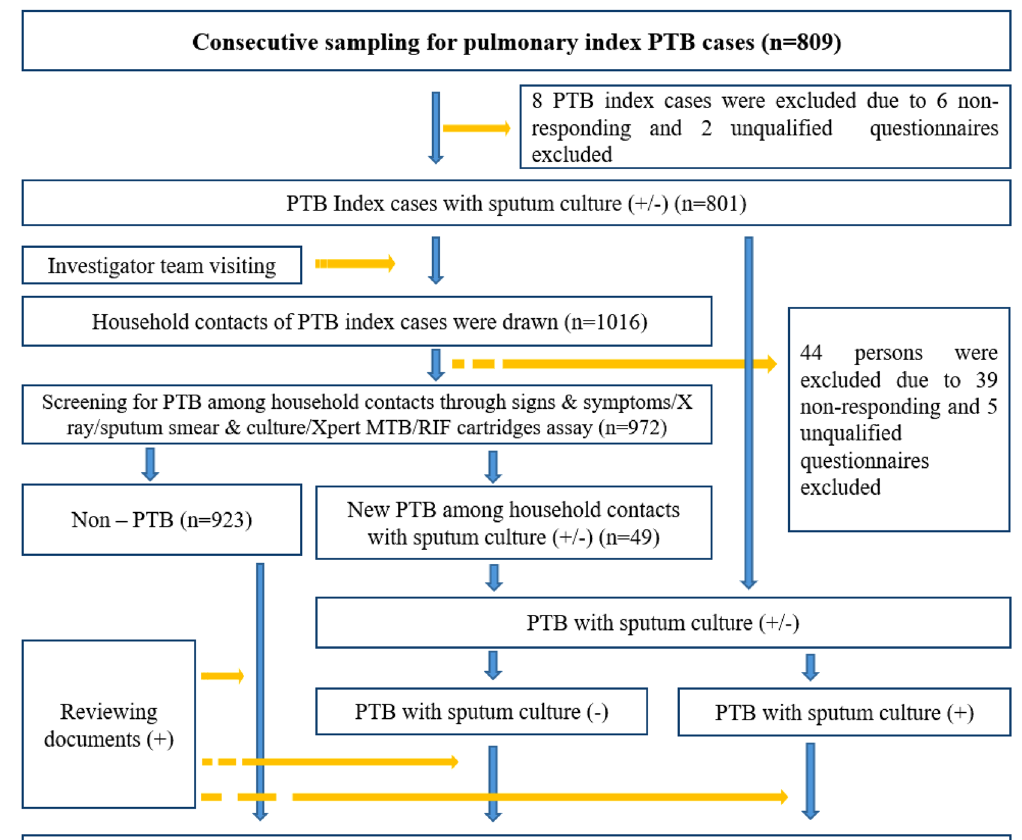
Figure 1. Flow chart of the study in Guizhou, China, 2020. PTB tuberculosis, DM diabetes mellitus, HbA1c glycosylated hemoglobin, FPG fasting plasma glucose, RPG random plasma